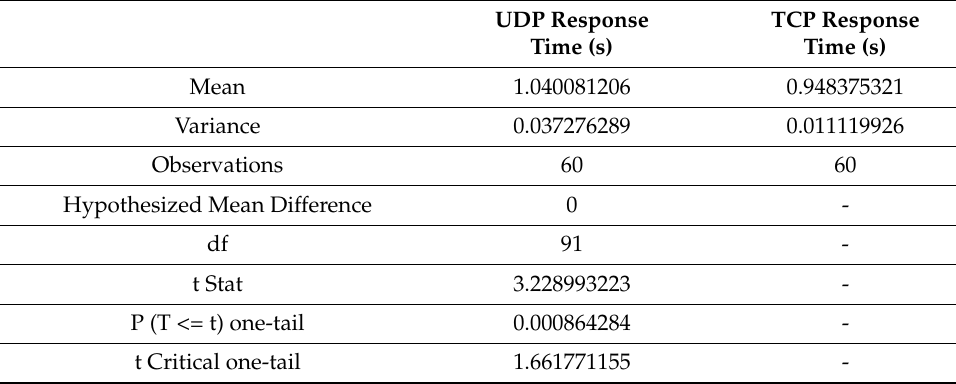
Table 7. Results, Experiment 4.